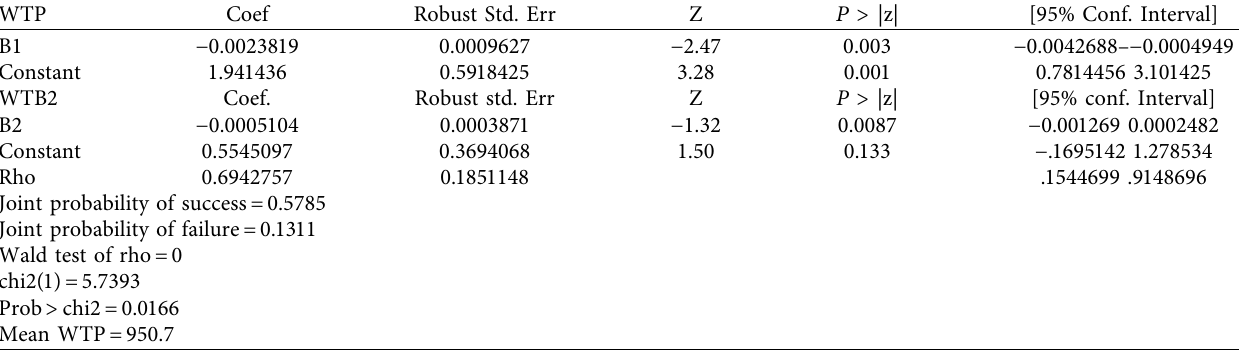
Table 7: Parameter estimates of a seemingly unrelated bivariate probit